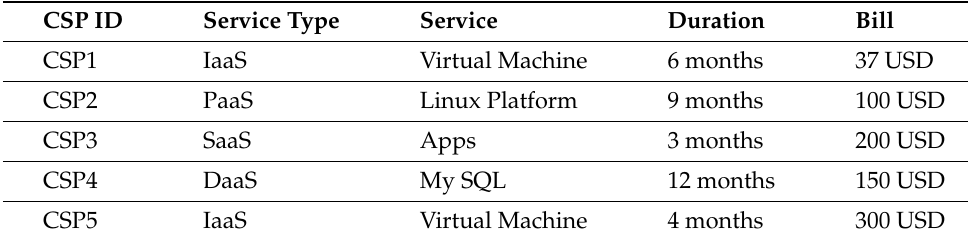
Table 3. Cloud Services.